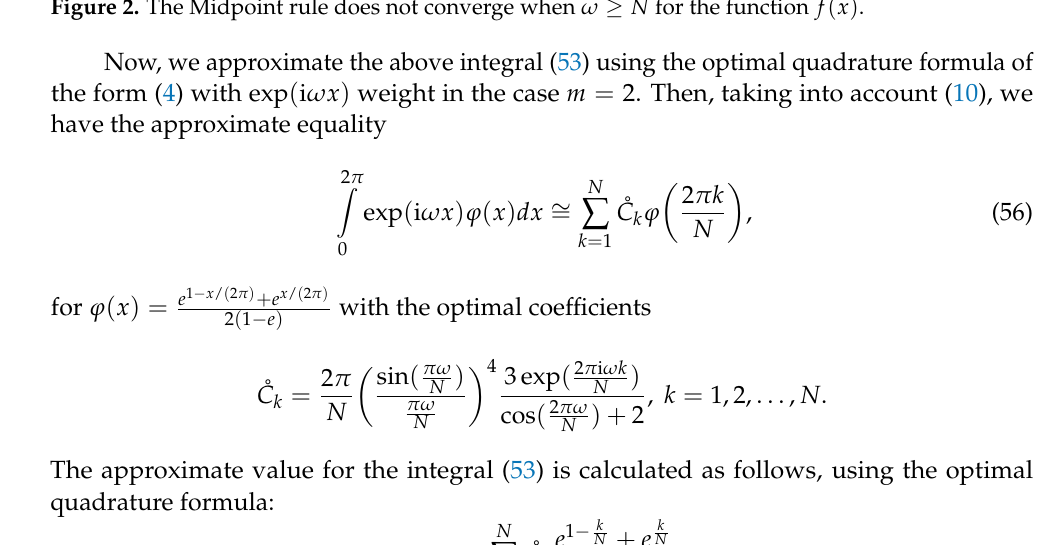
Figure 2. The Midpoint rule does not converge when ω ≥ N for the function f ( x )